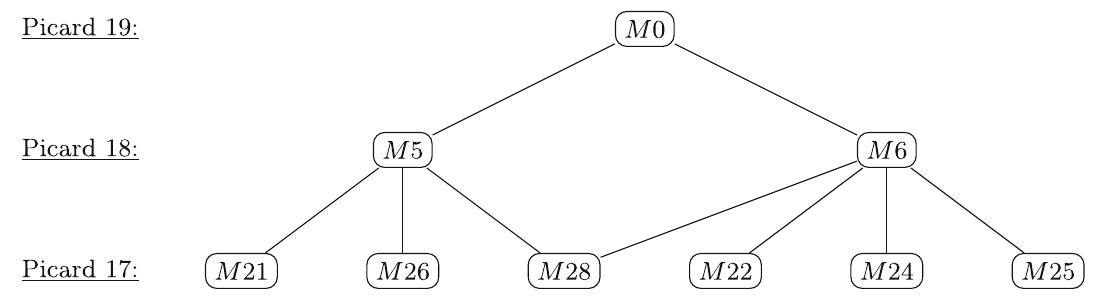
Fig. 2 In order to obtain the groups associated with the extended Dynkin diagrams on the N lattice we consider the following rays when the two dimensional subpolytopes are F13, F15 and F16